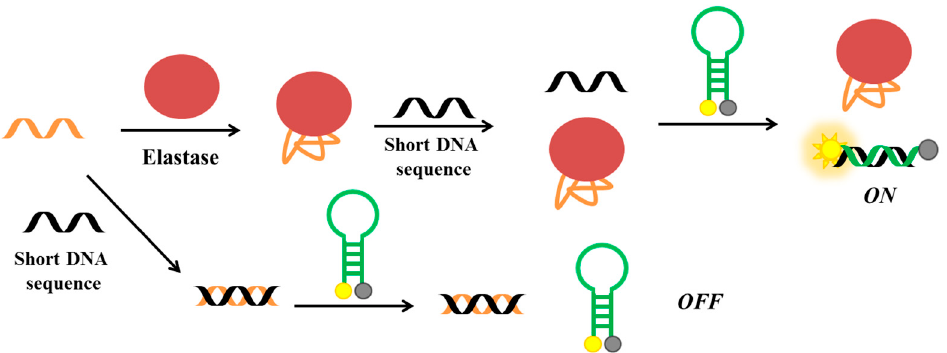
Figure 17. Schematic representation of elastase detection strategy based on competitive-binding involving the elastase aptamer, a molecular beacon and a short DNA sequence [138].